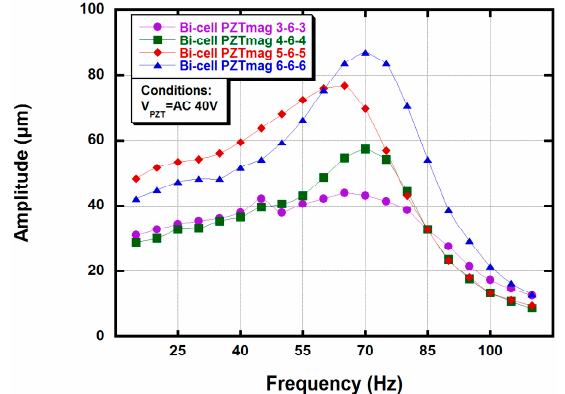
Figure 8. Maximum amplitude of the PDMSmag at 40 V when the bi-cell PZTmag–PEMFC stack was assembled.